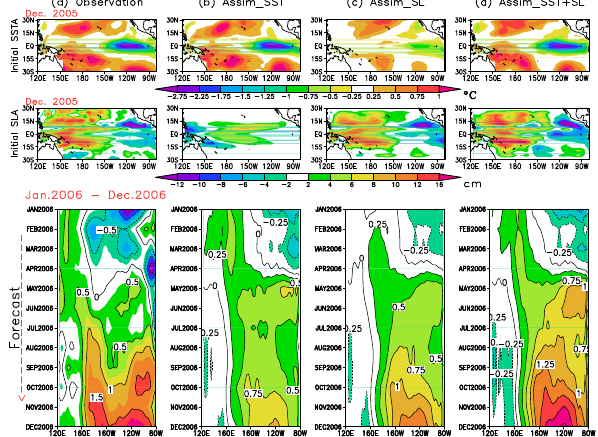
Figure 2. Initial conditions of anomalous SST (top row), SL (mid- dle row), and forecasted SST anomalies (bottom row) from the (a) observations, (b) Assim_SST results, (c) Assim_SL results, and (d) Assim_SST + SL results, respectively. The initial fields are from December 2005, and the 12-month forecasts start in January